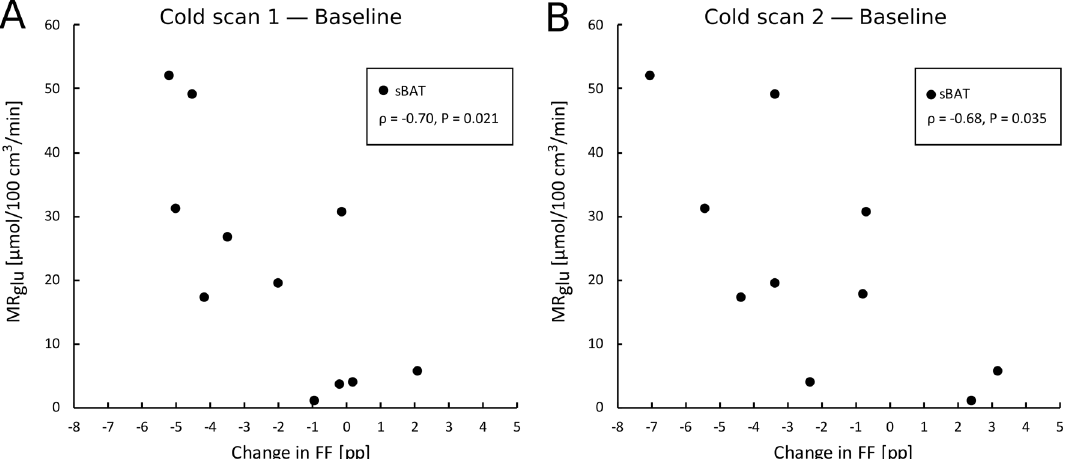
Figure 6. Correlation between cold-induced MR glu and changes in FF. sBAT-MR glu vs. the change in sBAT-FF between baseline and (A) ~ 3 h of cold exposure (cold scan 1) and (B) ~ 4.5 h of cold exposure (cold scan 2). ρ, Spearman rank-order correlation